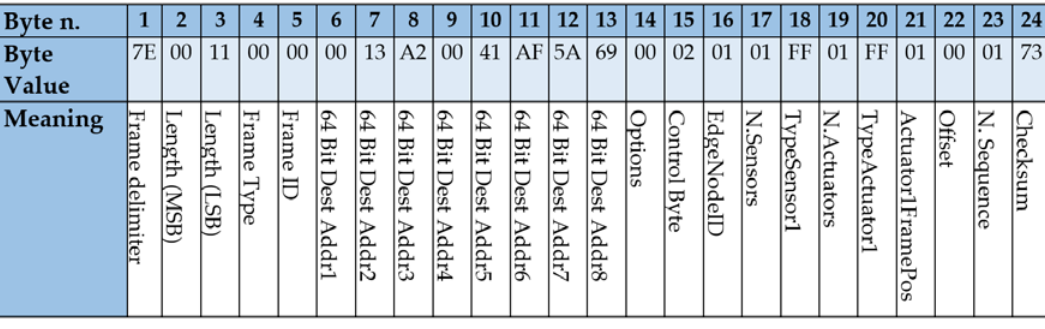
Figure 6. Configuration frame sent by the Wireless Controller to one Edge Node for a SISO control system.